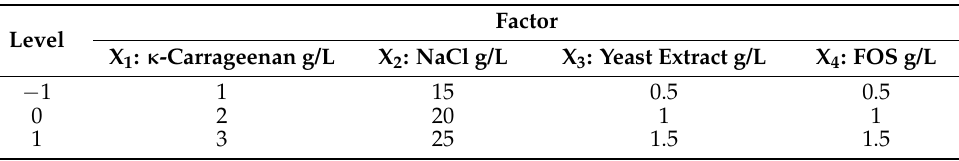
Table 7. Factors and levels of response surface